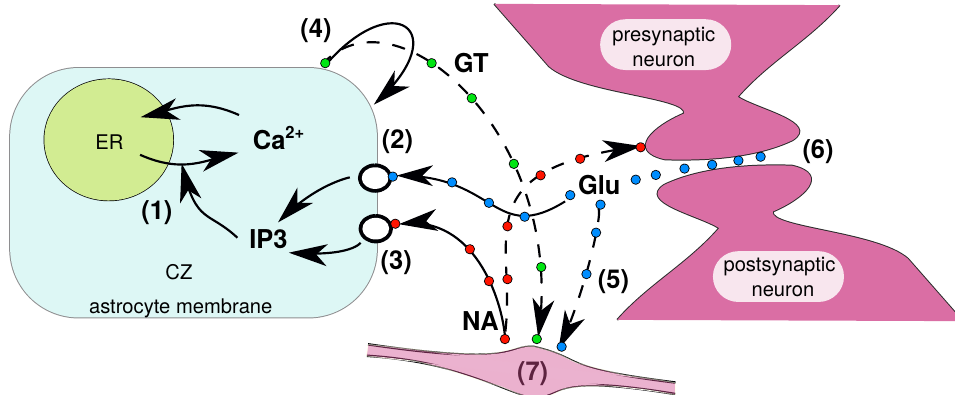
Figure 1. Modeled mechanisms. (1)—Calcium subsystem, including the processes of exchange between the cytosol (CZ) and the internal stores ER of the cell; (2)—Glu receptors; (3)—NA receptors; (4)—gliotransmitter (Gt) release; (5)—intercellular space; (6)—synapse; (7)—varicosites on the axon of an adrenergic neuron releasing NA. GANE pathways are shown with dashed